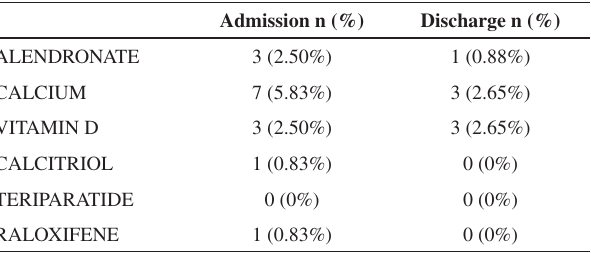
Table 1 - Type of treatment on admission and at